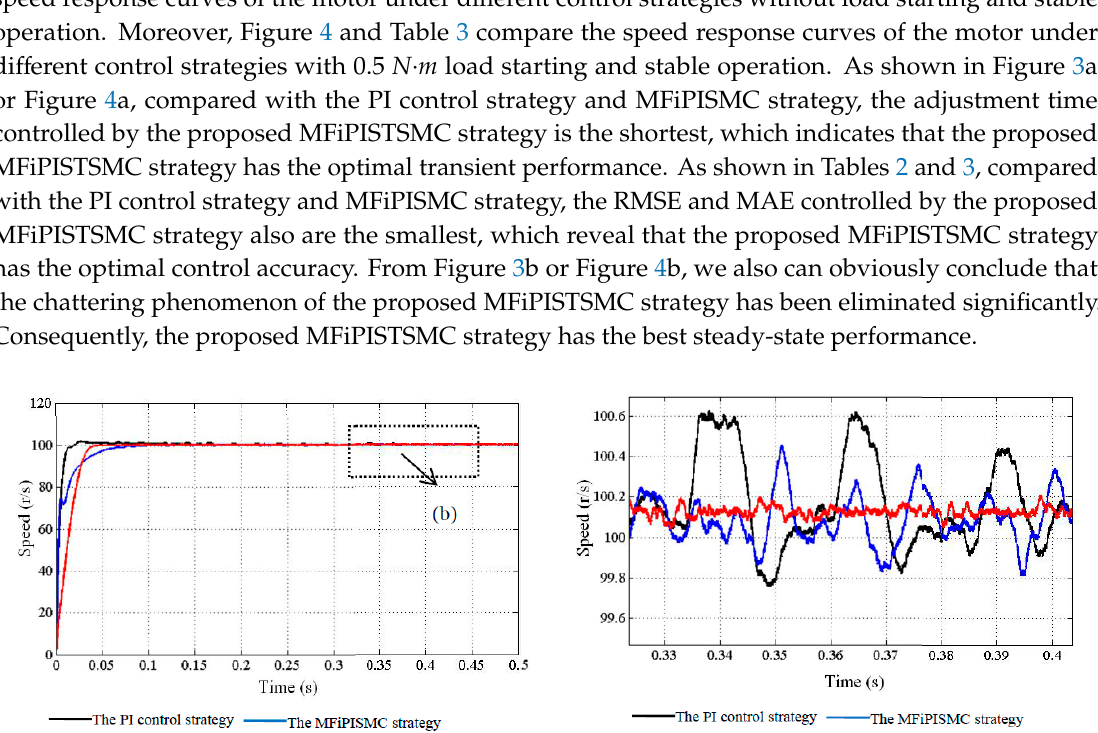
Table 2. The comparative results of the speed response curves without load.